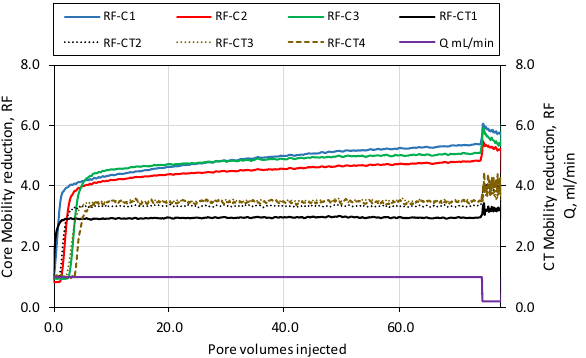
Fig. 6 Experiment 2, 2700 ppm A06 in SSW in Bentheimer. RF as a function of pore volumes injected in Cores and capillary tubes (CT). T1 = 20 °C, T2 = 60 °C and T3 = 80 °C. The volumetric injection rate is 1 ml/min from 0 to 81 pore volume, 2 ml/min from 81 to 99 pore volumes, 0.5 ml/min from 99–131 PV and is thereafter decreased to 0.2 ml/min from 131–189 pore